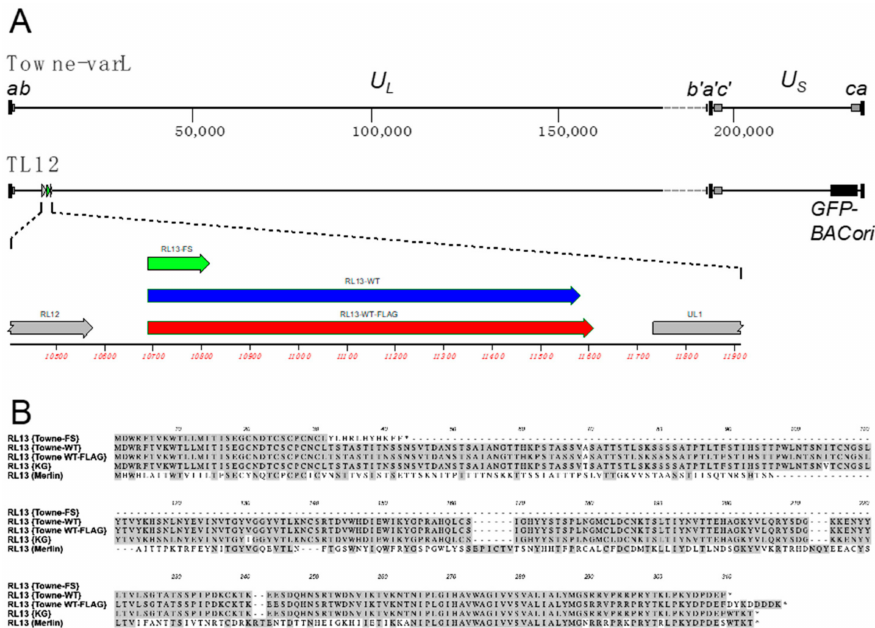
Figure 1. The CMV strain Towne genome and genetic modifications made to RL13 . ( A ) Top: map of the strain Towne-varL genome showing the a , b , and c sequences and their inverted a (cid:48) , b (cid:48) , and c (cid:48) sequence duplications that flank the unique-long ( U L ) and unique-short ( U S ) regions. A gray dashed line indicates U L /b (cid:48) sequences that are present in Towne-varL but deleted in Towne-varS. Bottom: map of the Towne-varL genome as cloned in BAC TL12 showing the location of RL13 and of the BAC origin/GFP cassette. Expanded area: RL13 open reading frames present in the parental virus TL12-RL13 FS , which contains a one-bp insertion that frame shifts and prematurely truncates RL13, in the TL12-RL13 WT virus, where the one-bp insertion has been removed, and in the TL12-RL13 WT-FLAG virus, in which sequences encoding a C-terminal FLAG epitope (DYKDDDDK) have been inserted. ( B ) ClustalW alignment of RL13 protein sequences as encoded by viruses TL12-RL13 FS , TL12-RL13 WT , and TL12-RL13 WT-FLAG . RL13 sequences encoded by strains KG and Merlin are included to illustrate that RL13 encoded by TL12-RL13 WT is similar to RL13 of KG but highly divergent from RL13 of